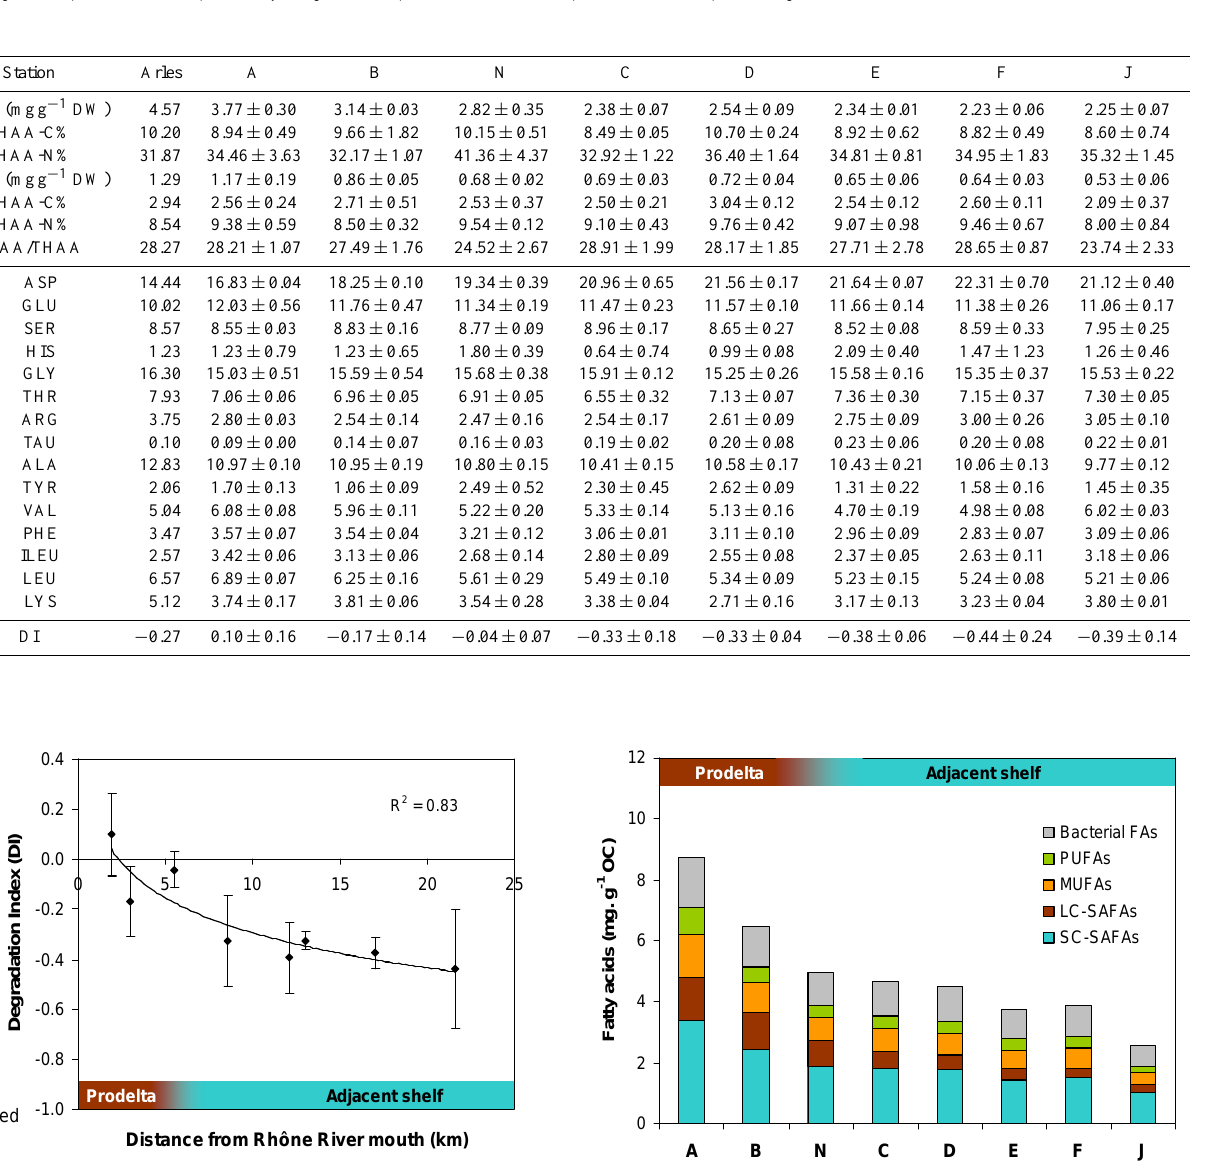
Fig. 3. Correlation between Degradation Index values (DI) and distance from the river mouth in the surface sediments (8 stations, 24 cores).